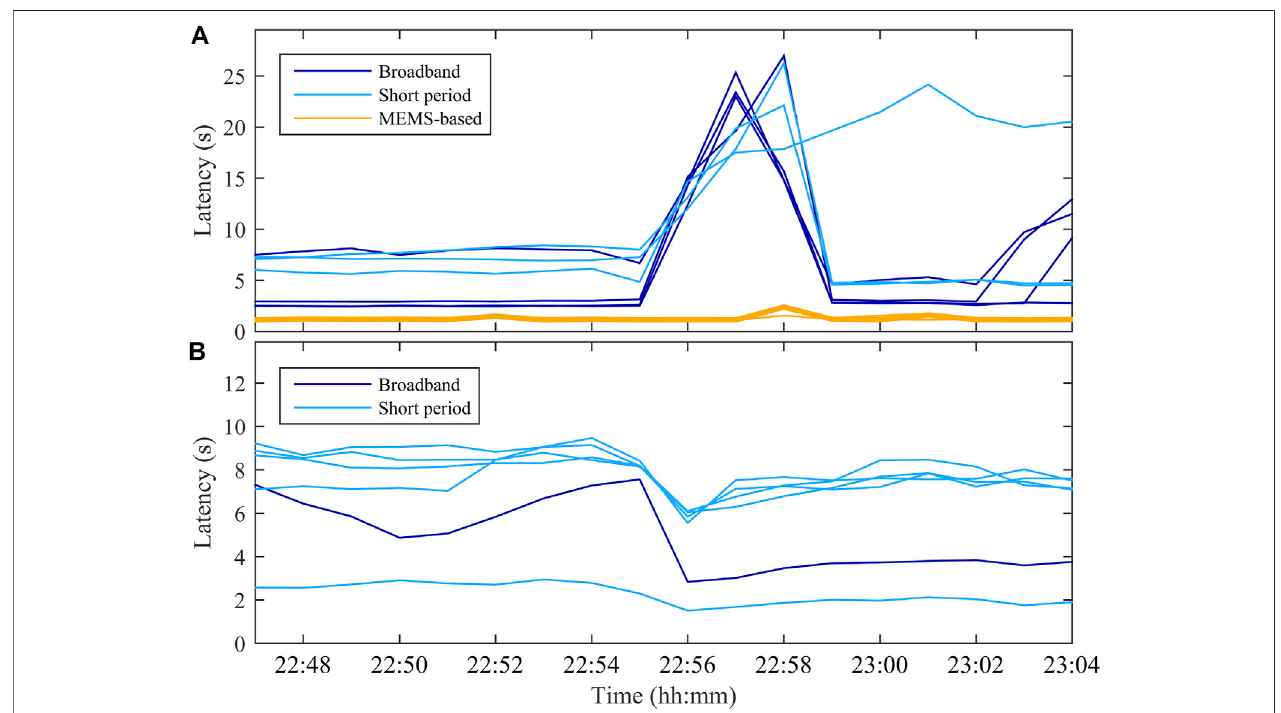
FIGURE 6 | Data latency responses of different stations types with real-time data being transmitted by (A) cellular modem links and (B) fi ber lines to the June 17, 2019 M 6.0 Changning earthquake.